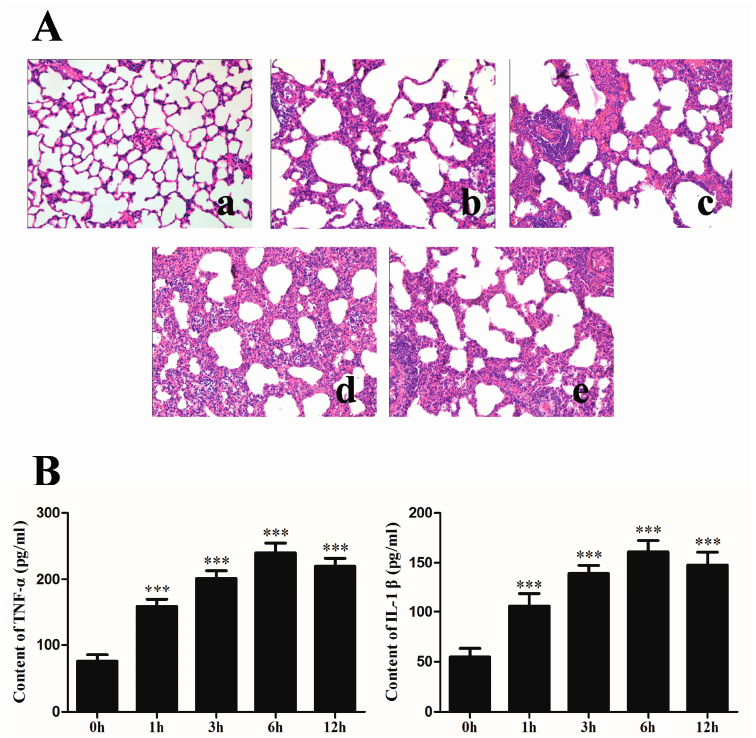
Figure 1. Changes of lung histopathology ( A ) and pro-inflammation cytokines expression ( B ) after seawater administration. ( a – e ) 0, 1, 3, 6 and 12 h seawater group. n = 8, *** p < 0.001 versus group a